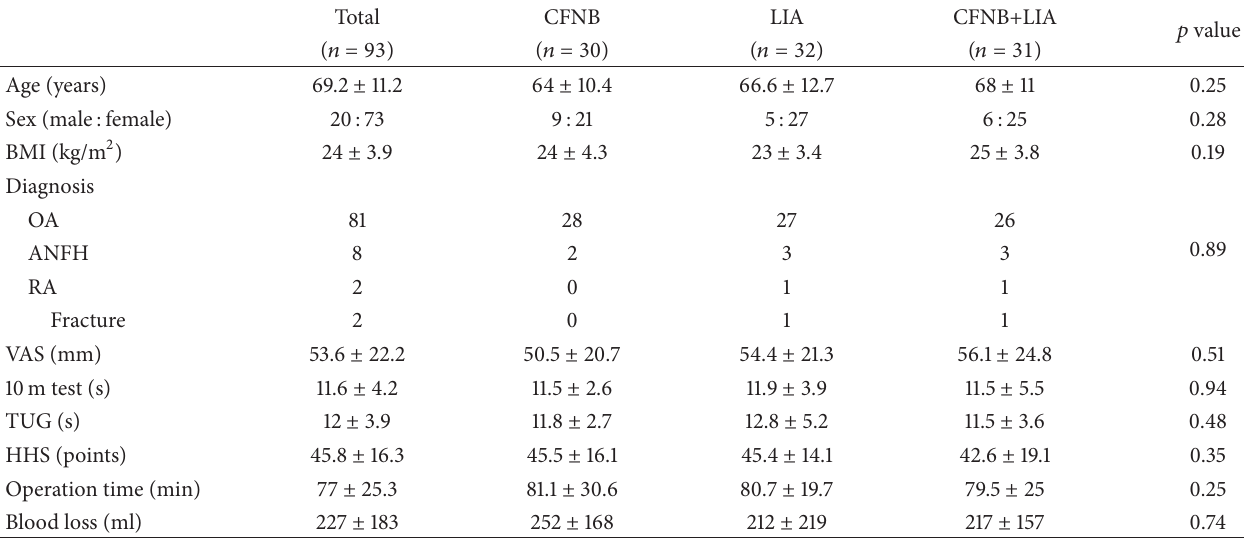
Table 1: Patient characteristics.